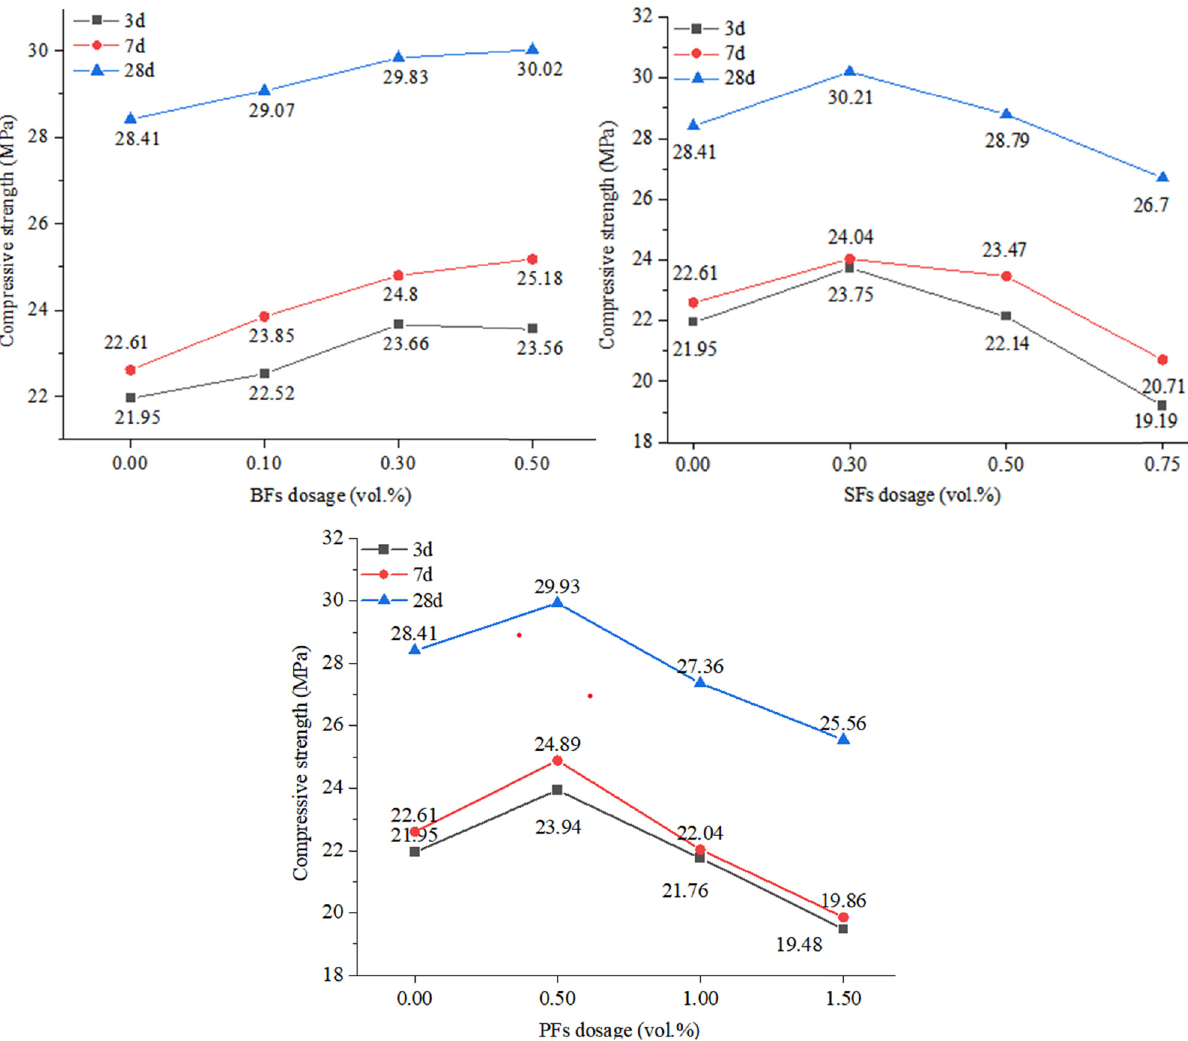
Figure 8: Compressive strength of